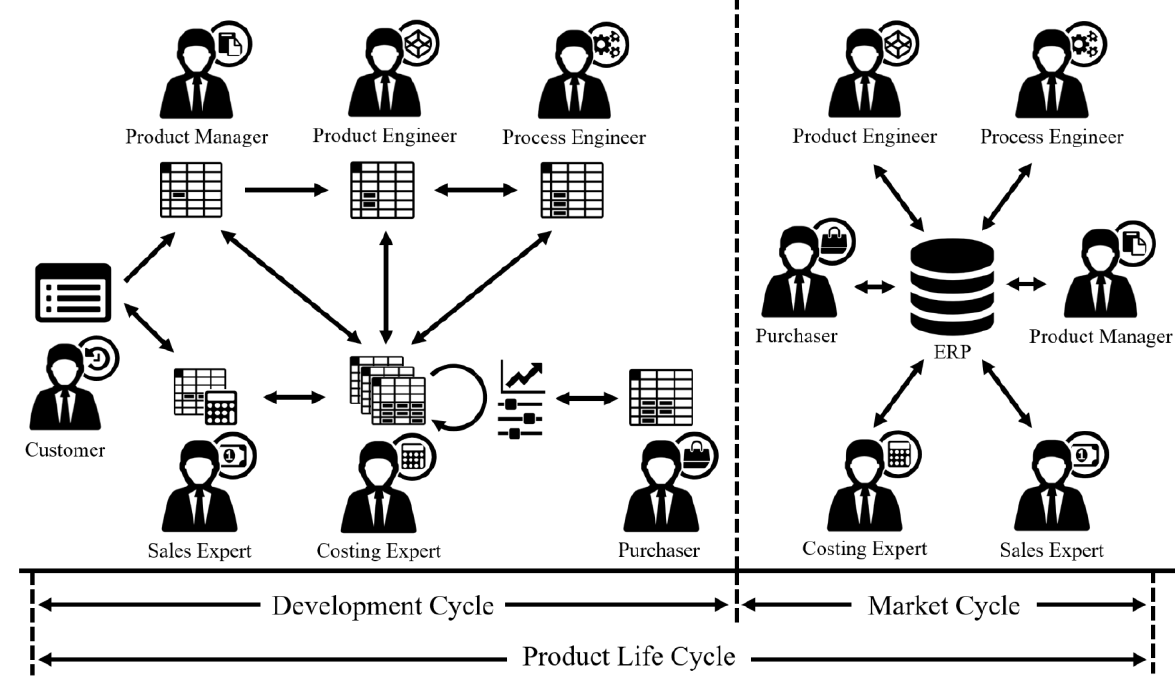
Figure 3. Software support within the development cycle in comparison to the market cycle